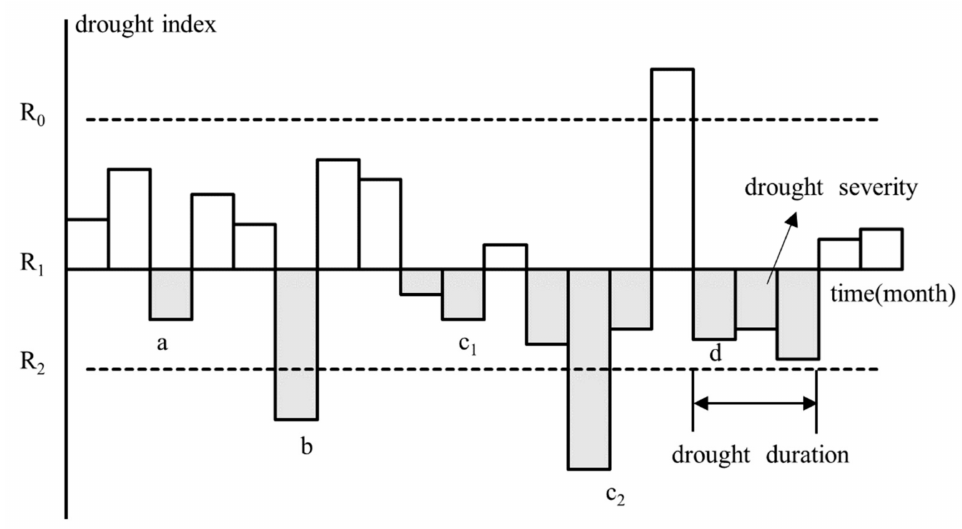
Figure 2. Based on the theory of the run extract drought characteristic variables.